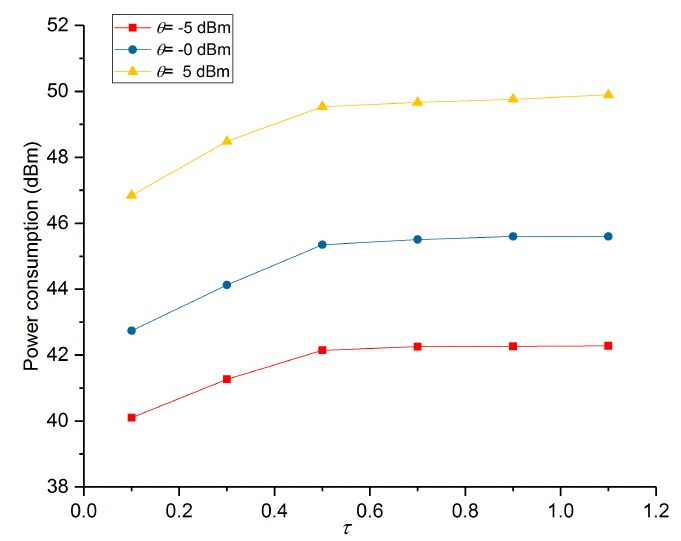
τ with different EH thresholds.